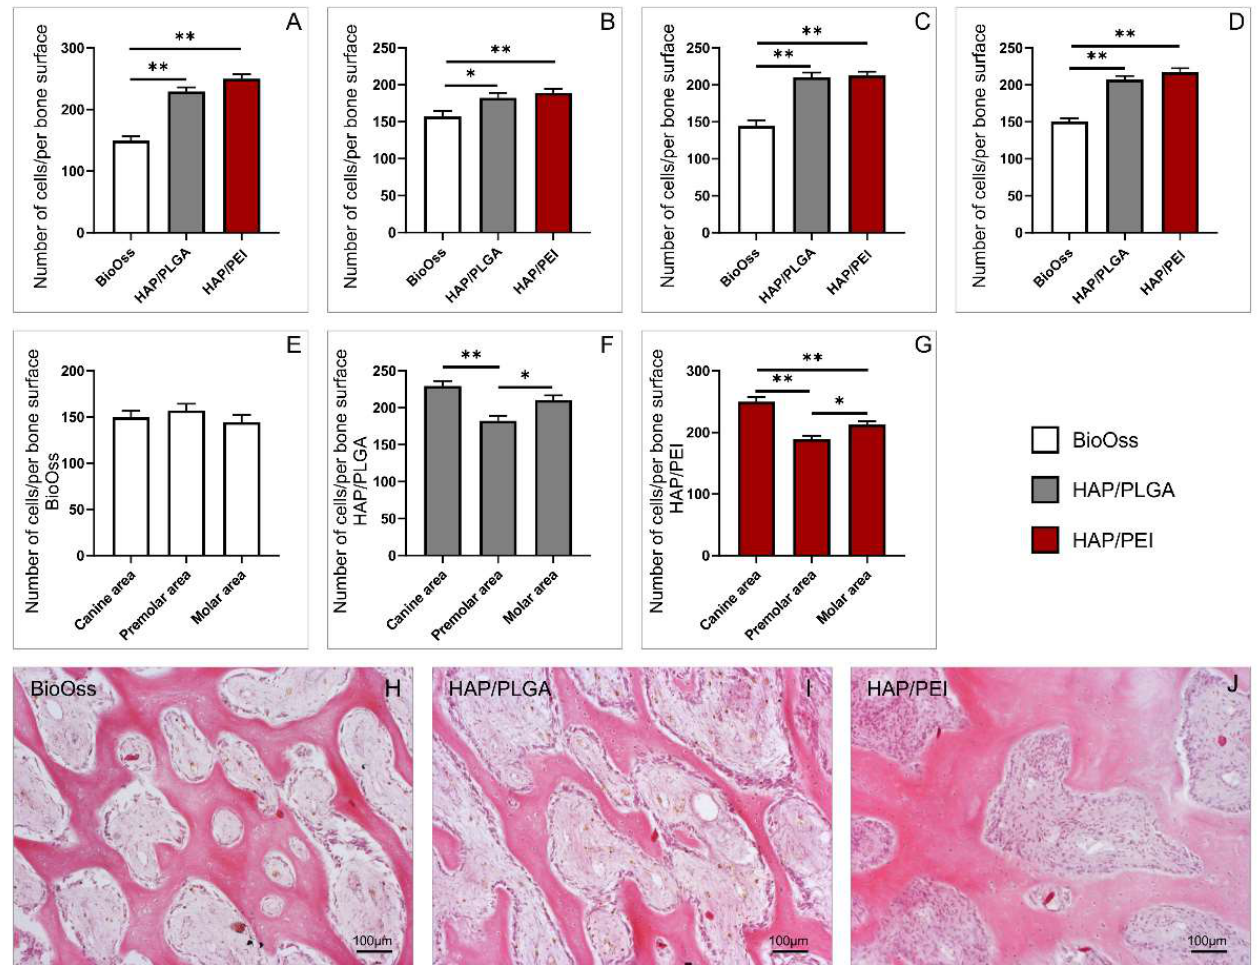
Figure 2. Number of cells/per bone surface: ( A ) canine area, ( B ) premolar area, ( C ) molar area, ( D ) whole mandibula, ( E ) BioOss graft, ( F ) HAP/PLGA graft, ( G ) HAP/PEI graft; representative images of H&E staining on paraffin-embedded sections (original magnification × 20): ( H ) BioOss graft, ( I ) HAP/PLGA graft, ( J ) HAP/PEI graft. The values are mean ± standard error of the mean (SEM), * denotes a significant difference p < 0.05, ** denotes a significant difference p < 0.01.